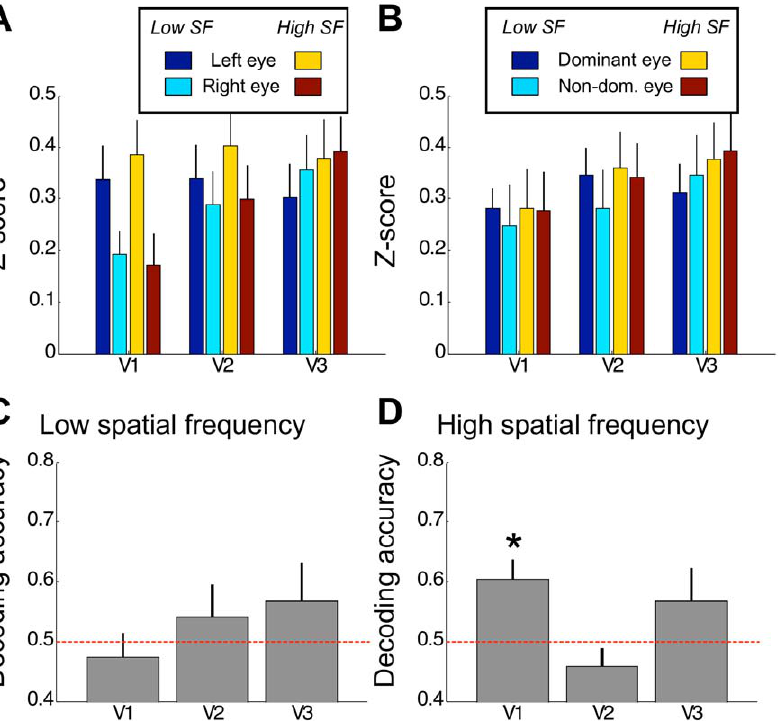
Figure 3. Mass-univariate response per condition. A–B. The signal change (z-score) averaged across the group of participants plotted for each ROI and stimulus condition. Data are grouped by anatomical eye (A) or by eye dominance (B). Error bars depict standard error of the mean. C–D. Univariate decoding stimulus eye-of-origin for the low spatial frequency stimulus (C) and the high spatial frequency stimulus (D). Decoding accuracy (proportion correct) obtained for the mean of the 100 most active voxels is plotted for the three ROIs averaged across participants. Error bars depict standard error of the mean. The asterisks indicate that accuracy was significantly above chance (permutation test, p , 0.01, Bonferroni corrected).